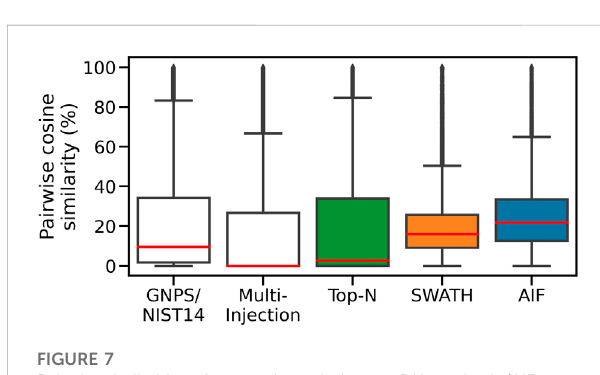
FIGURE 7 Pairwise similarities of spectra in each dataset. DIA methods (AIF, SWATH) produce deconvoluted spectra that are more similar to each